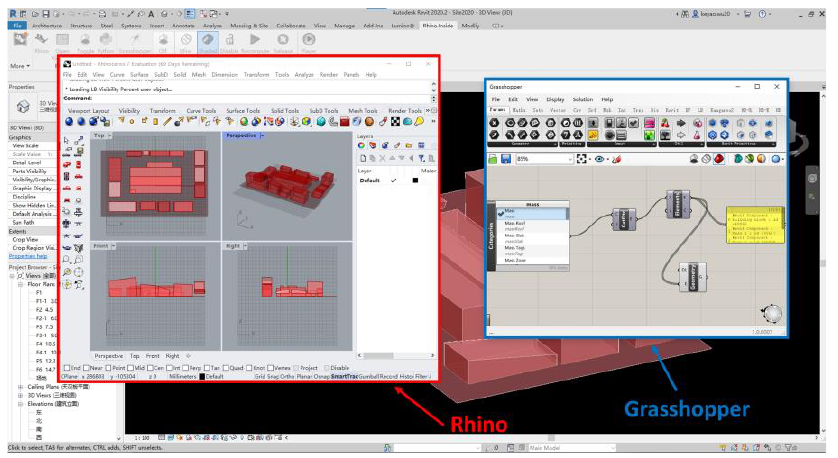
Figure 2. Rhino inside Revit.